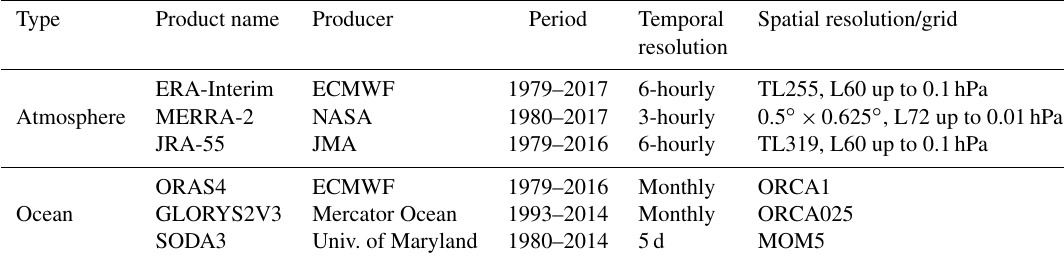
Table 1. Basic specification of reanalyses products included in this